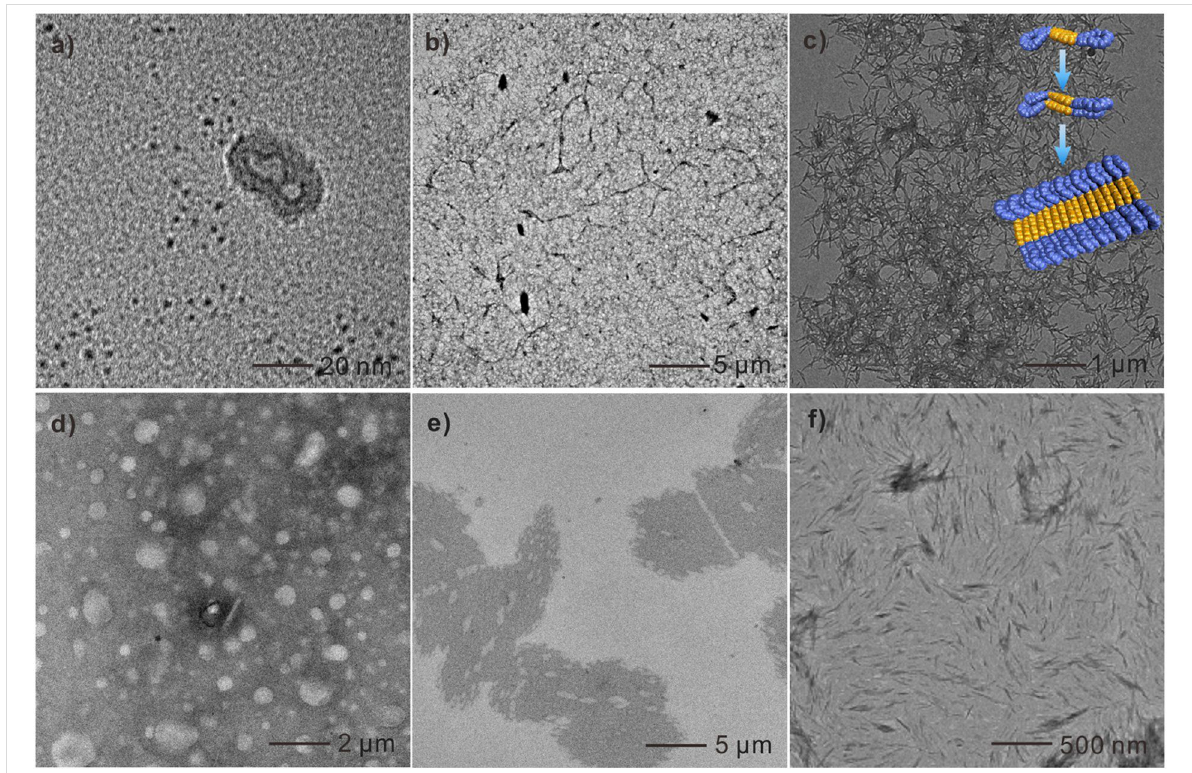
Figure 2: TEM images of 1 aggregates in (a) CHCl 3, (b) MeCN, and (c) H 2 O/MeCN (v/v = 10:1) (inset: schematic space-filling models illustrating the self-assembly of 1 ); TEM images of 2 aggregates in (d) CHCl 3 , (e) MeCN, and (f) H 2 O/MeCN (v/v = 10:1). Concentration of solutions for all the TEM analysis is 1 × 10 − 4